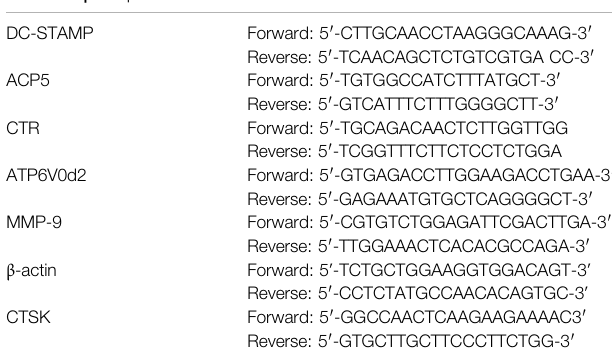
TABLE 1 | The primer sets used are as